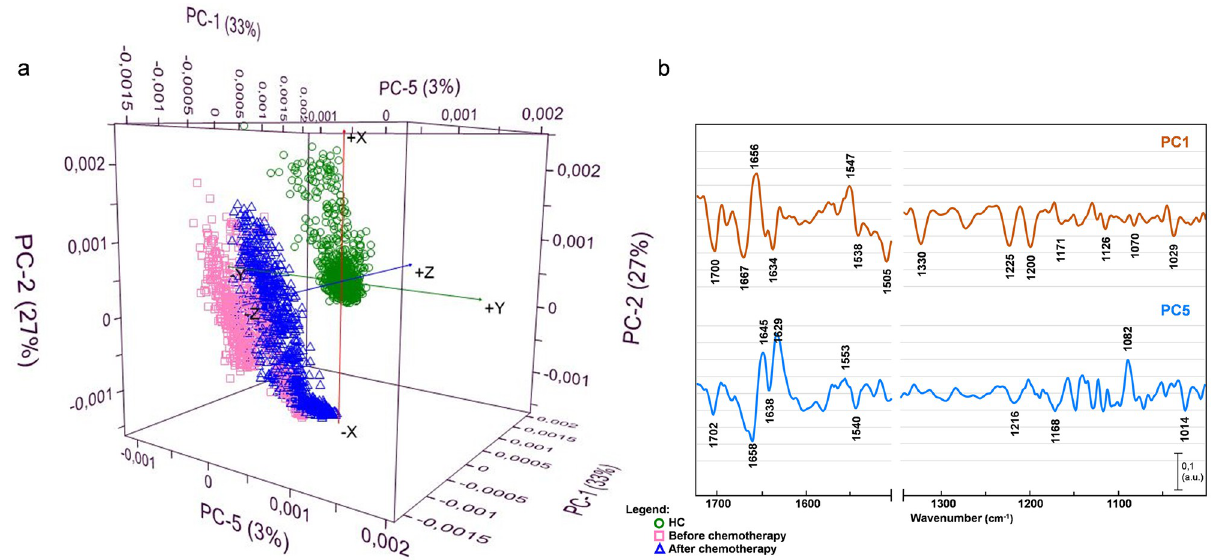
Fig 7. Principal component analysis performed on TNBC and healthy control spectral sets. PCA scores (a) and loadings (b) plots with the inclusion of the datasets from healthy control (green circle), before chemotherapy (pink square), and after chemotherapy (blue triangle).